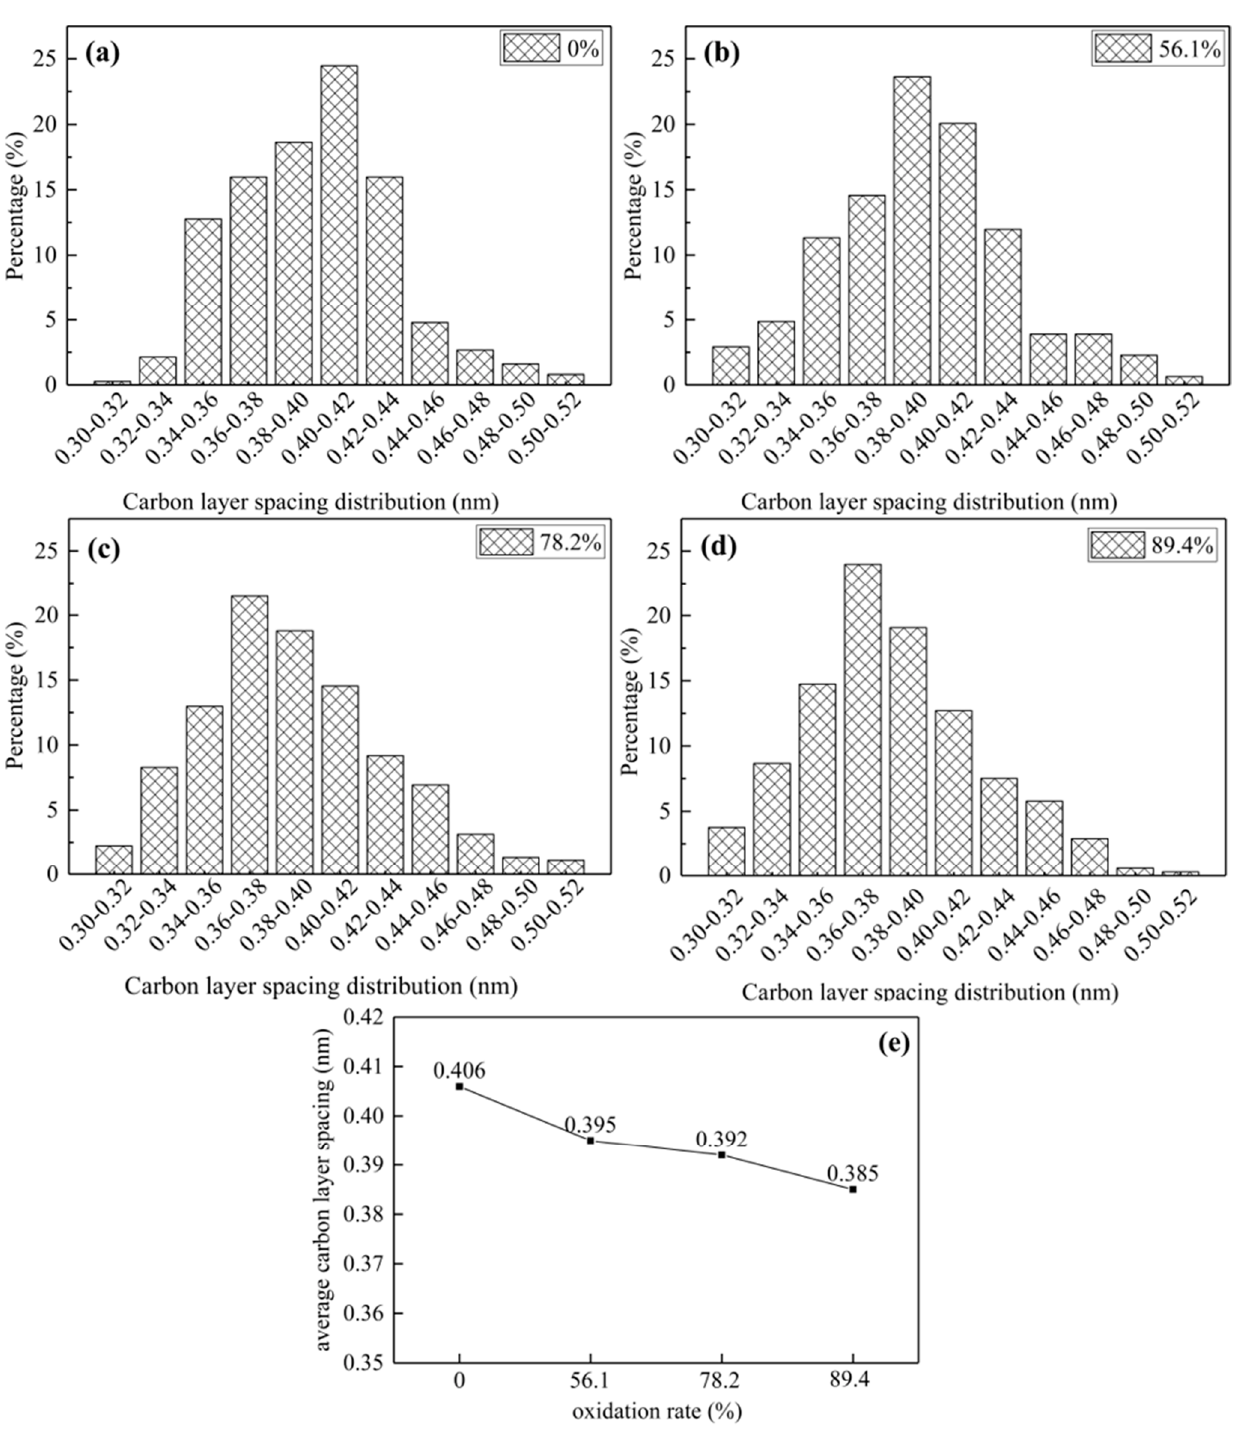
Figure 6. Carbon layer spacing distribution and average interlayer spacing for different soot oxida- tion rates: ( a ) 0%, ( b ) 56.1%, ( c ) 71.2%, ( d ) 89.4%, ( e ) average carbon layer spacing.